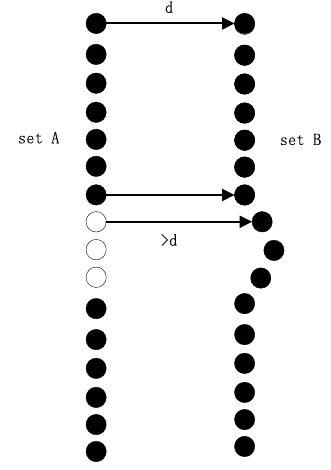
Figure 3. A geometric interpretation of partial Hausdorff distance.